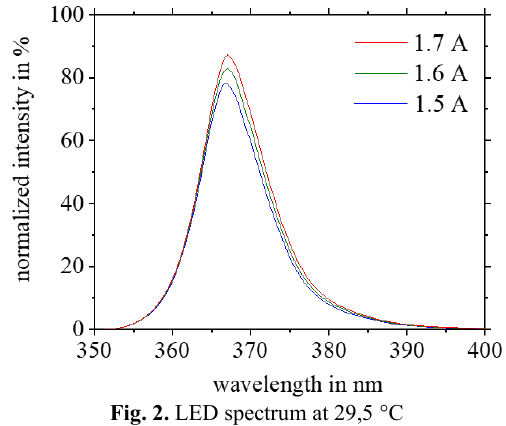
Fig. 2. LED spectrum at 29,5 °C